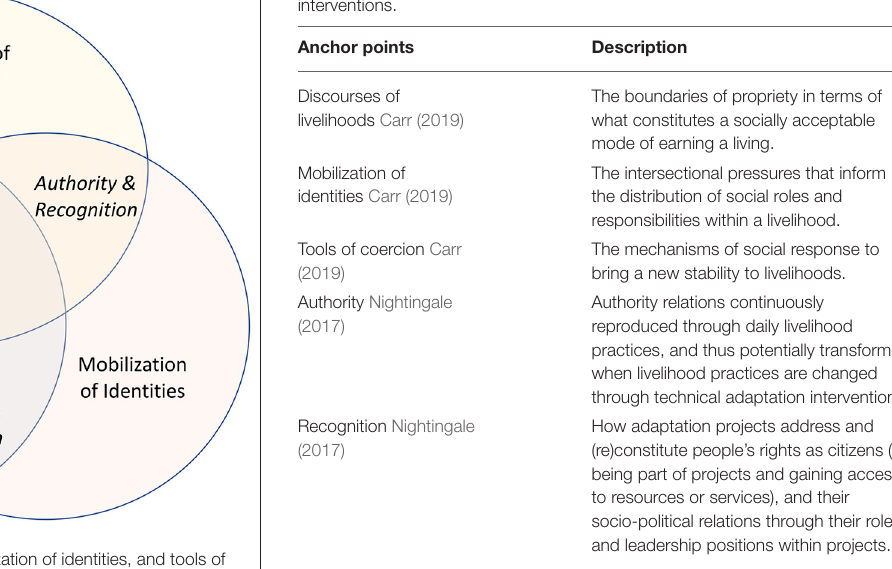
FIGURE 1 | Discourses of livelihoods, mobilization of identities, and tools of coercion are spheres of everyday life that shift in relation to each other to pursue material and socio-political resilience in the face of shocks. The interaction between the three spheres determines the decision-making space for CSA and livelihood practices, leading to socially differentiated outcomes. In turn, CSA projects intervene in authority relations and recognition, thereby shifting the three spheres and gendered space for livelihood decision-making.